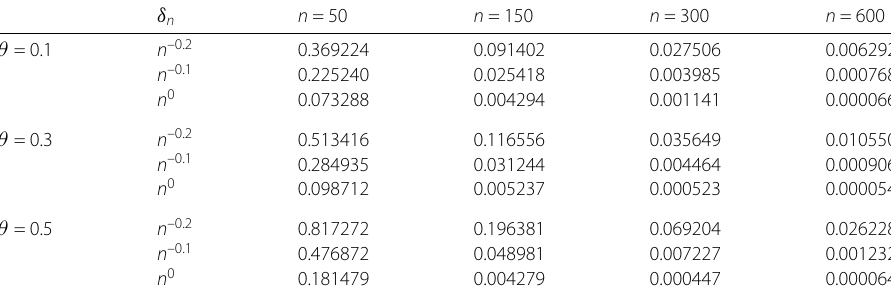
Table 1 MSE of the estimator ˆ τ n ( θ ) with different θ and δ n δ n n = 50 n = 150 n = 300 n = 600 θ =